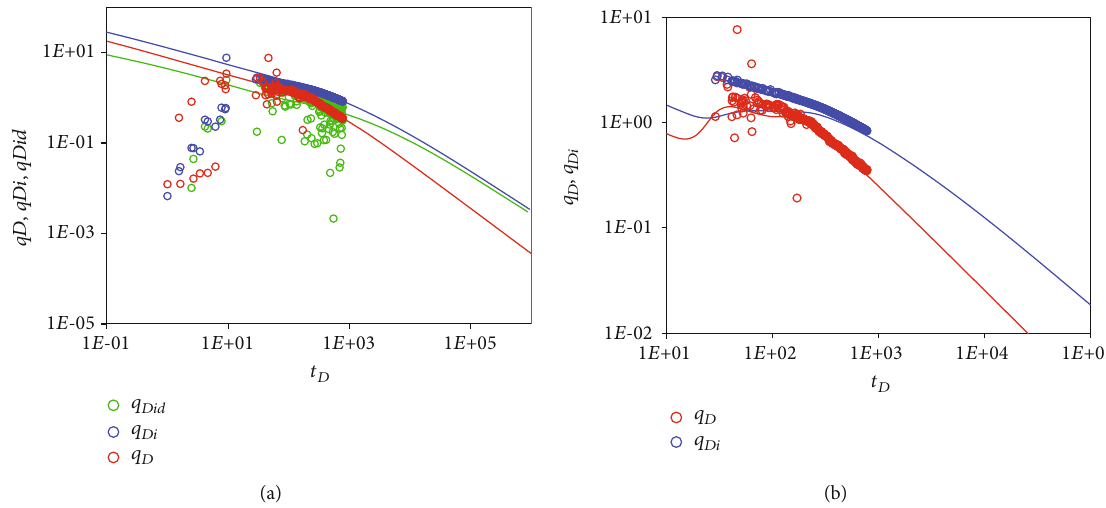
Figure 17: Type curve fi tting of YY-5 production data considering (a) and ignoring (b) the uneven support of